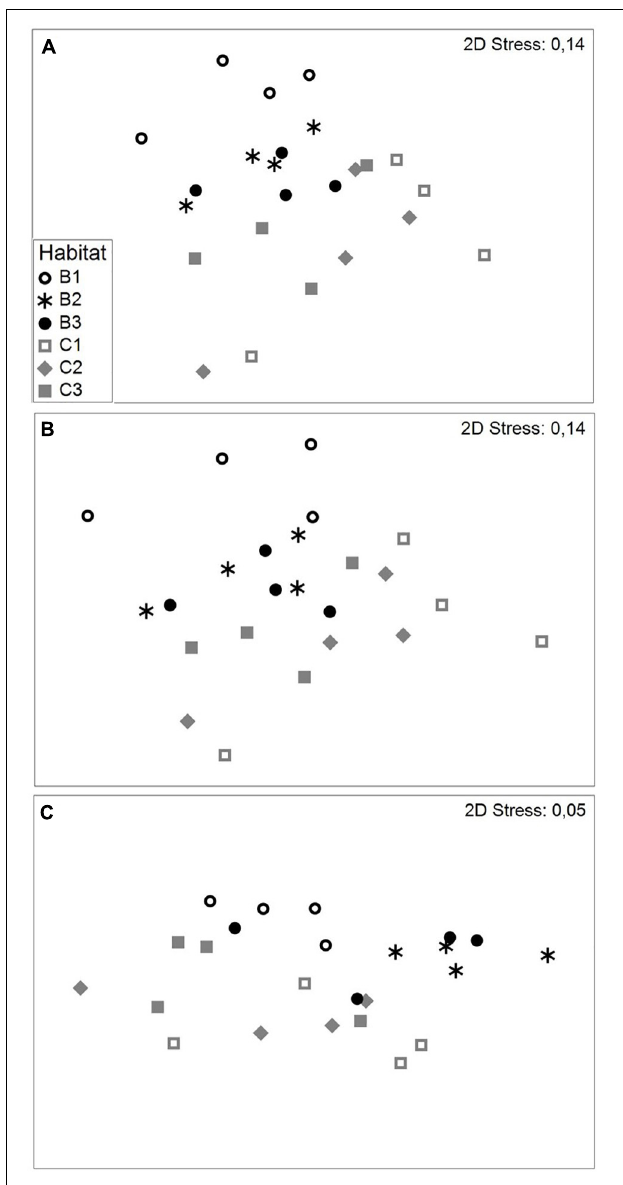
FIGURE 4 | nMDS for (A) abundance (B) biomass as well as (C) the abundance-corrected trait expression between habitats during all seasons.